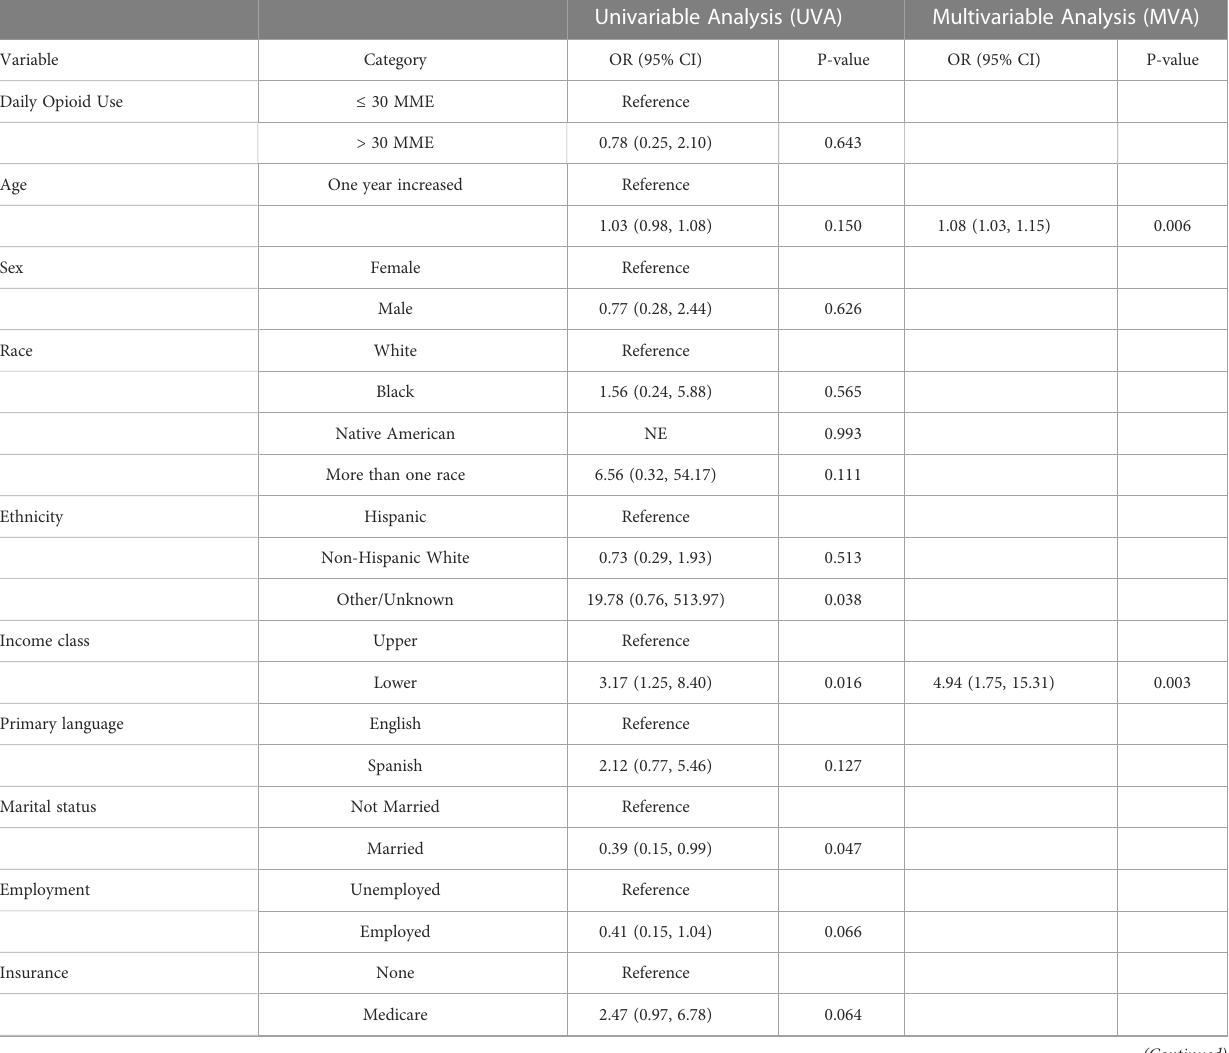
TABLE 4 Factors in fl uencing radiation treatment